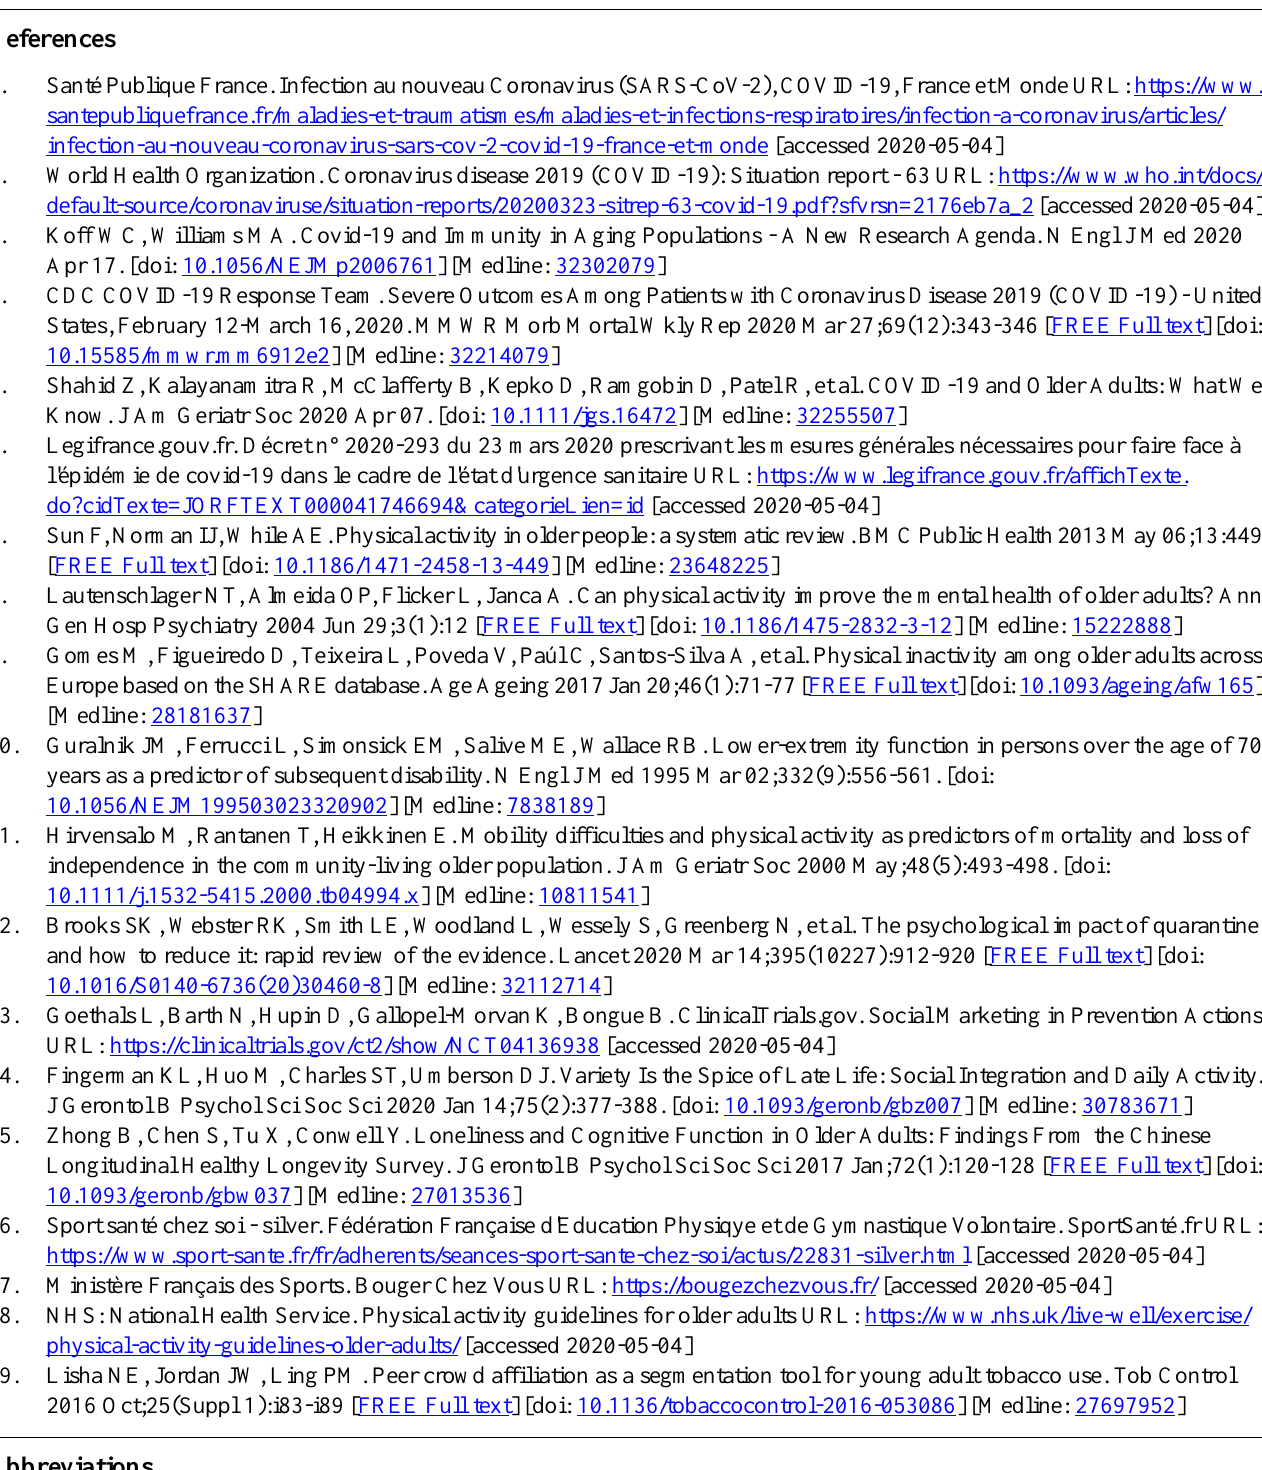
COVID-19: coronavirus disease FFPEVG: French Federation of Physical Education and Voluntary Gymnastics SARS CoV-2: severe acute respiratory syndrome coronavirus 2 SMAPE: Social MArketing and Physical activity in